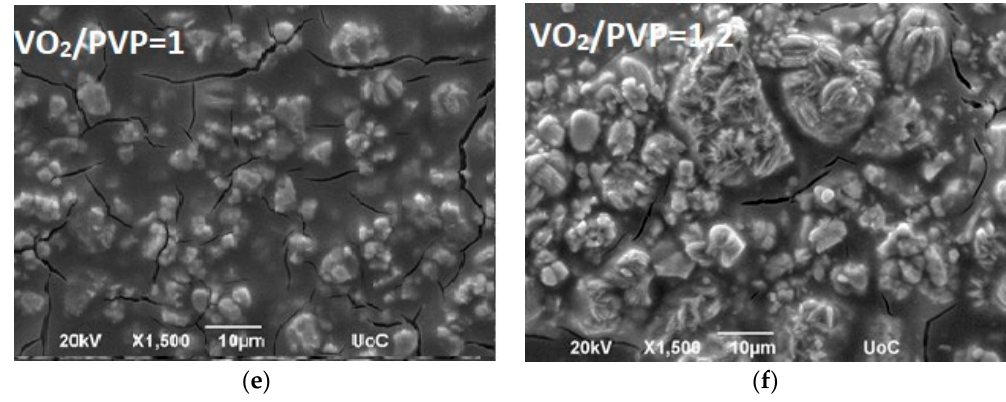
Figure 3. SEM images of VO 2 /PVP nanocomposite films with a different molar ratio of VO 2 : PVP from 0.2 to 1.2.